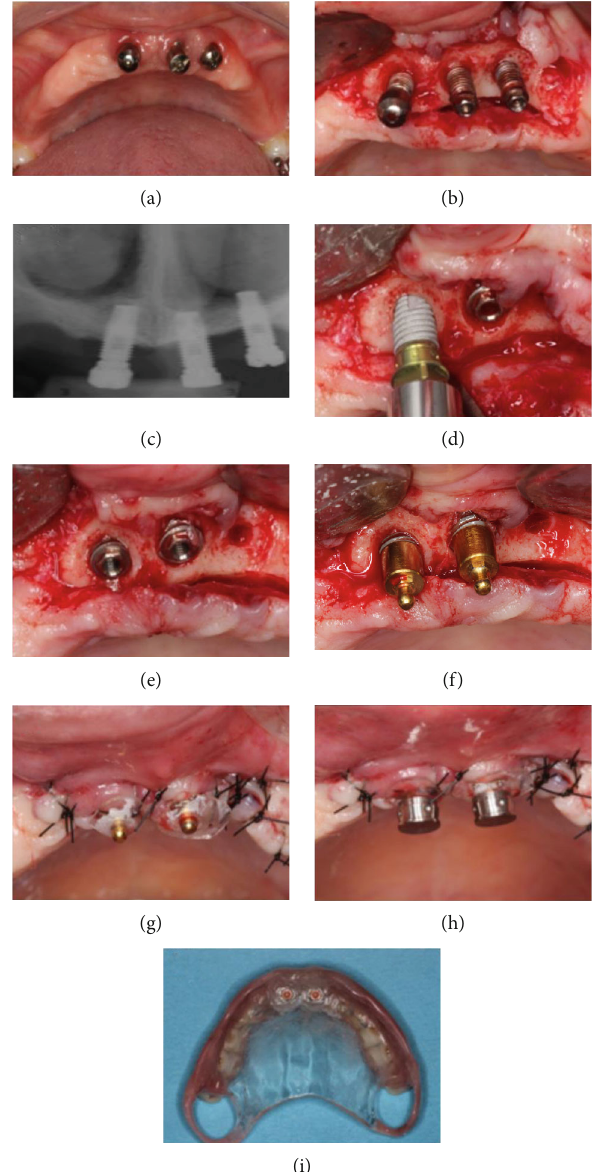
Figure 4: The fi rst step in the surgical procedures was to expose the area where the implants were installed, and then, the implants were removed (a – c). After implant removal, two short implants were immediately installed. An appropriate abutment was installed in each of the implants to allow provisional prosthesis installation with appropriate retention (d –